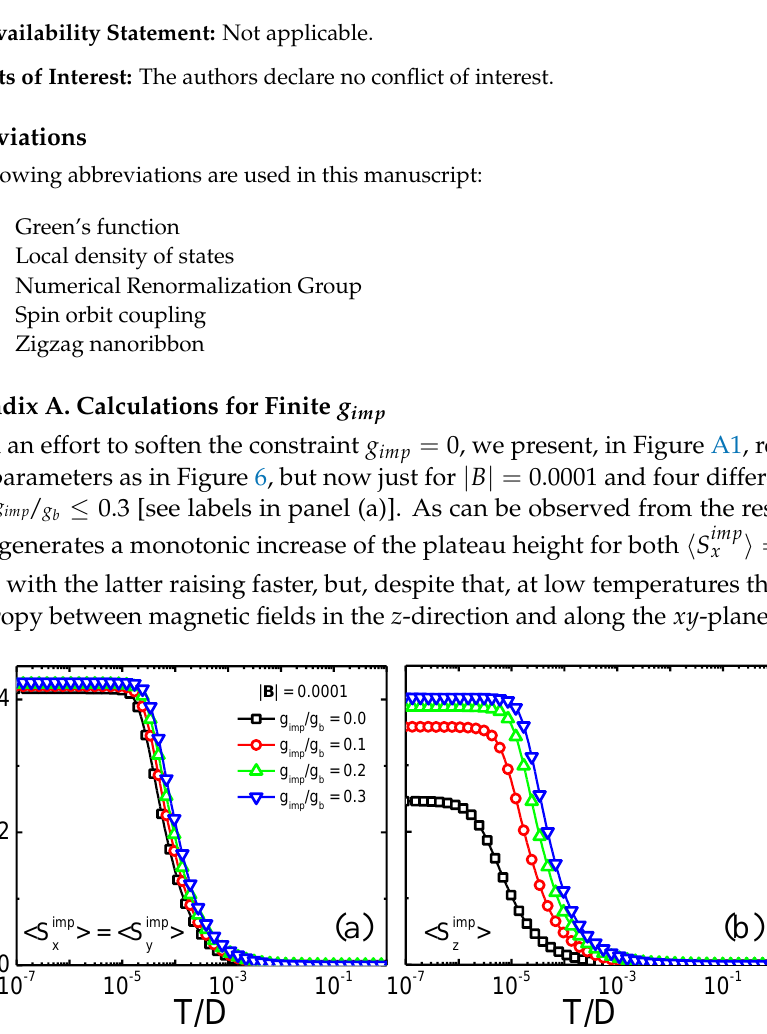
Figure A1. Same results as in Figure 6, but now just for external magnetic field strength | B | = 0.0001 and four different values of 0.0 ≤ g imp / g b ≤